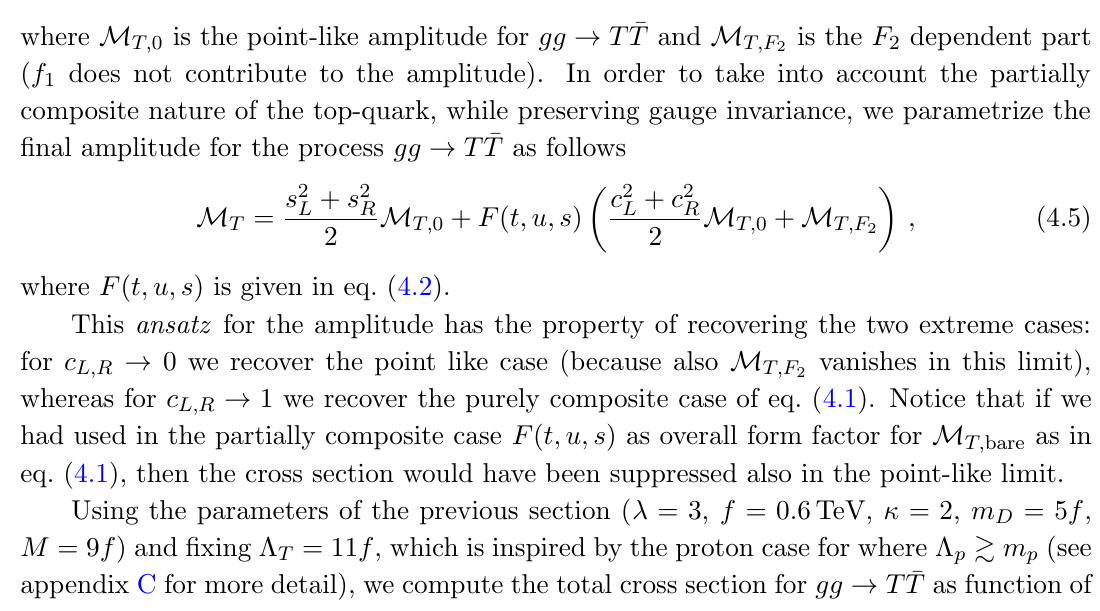
Figure 5 . Cross section for gg ! T (cid:22) T as function of center of mass energy in the partially composite case (red). Purely-composite (blue) and point-like (green) cases are also shown for comparison. Values of parameter used: (cid:21) = 3, f = 0 : 6 TeV, (cid:20) = 2, m D = 5 f , M = 9 f and (cid:3) T = 11 f